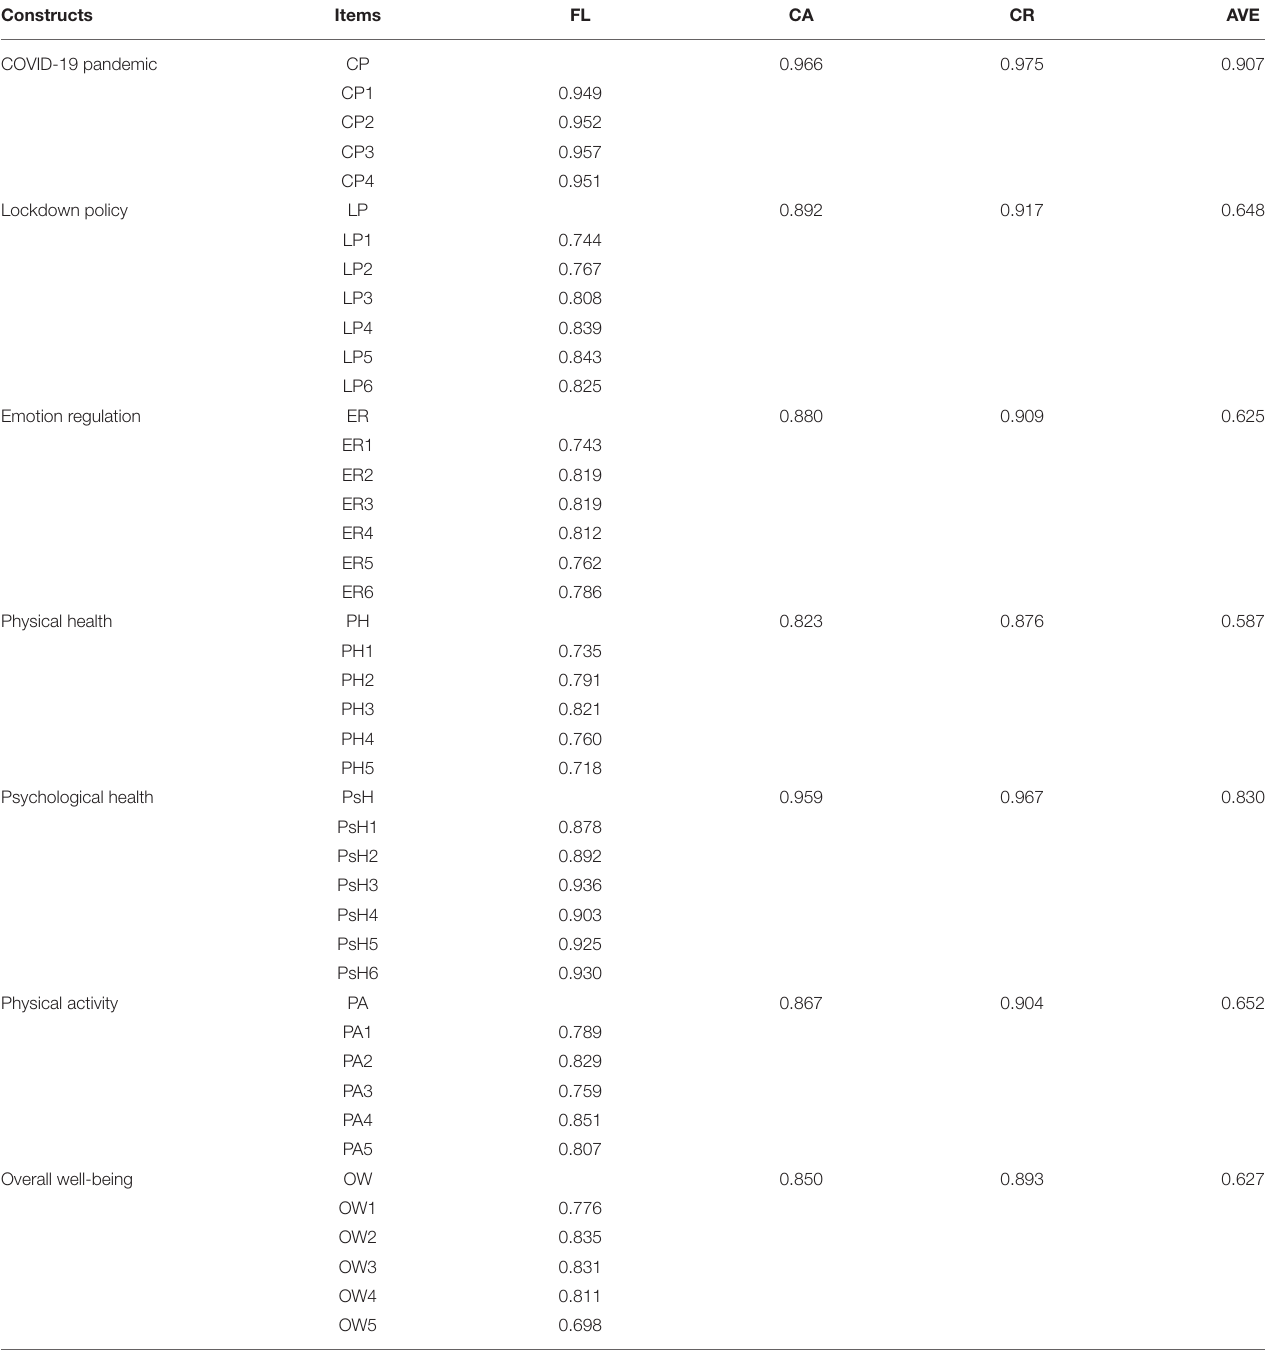
TABLE 2 | Construct validity and reliability ( N =